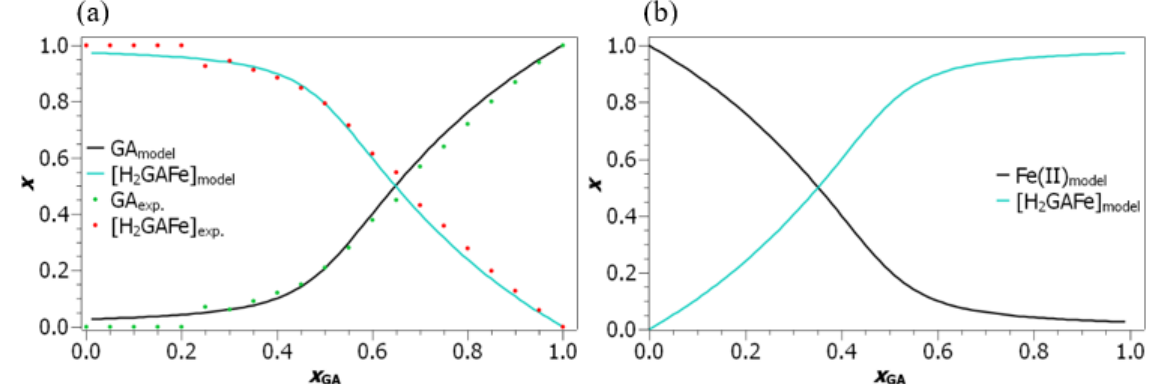
Figure 8. ( a ) Dependence of the molar fraction ( x ) of gallic acid present in the free form and of gallic acid bound in the coordination compound on x GA for sample sets with the pH of 5.50. ( b ) Dependence of the molar fraction ( x ) of iron(II) ions present in the free form and iron(II) ions bound in the coordination compound on x GA for sample sets with the pH of